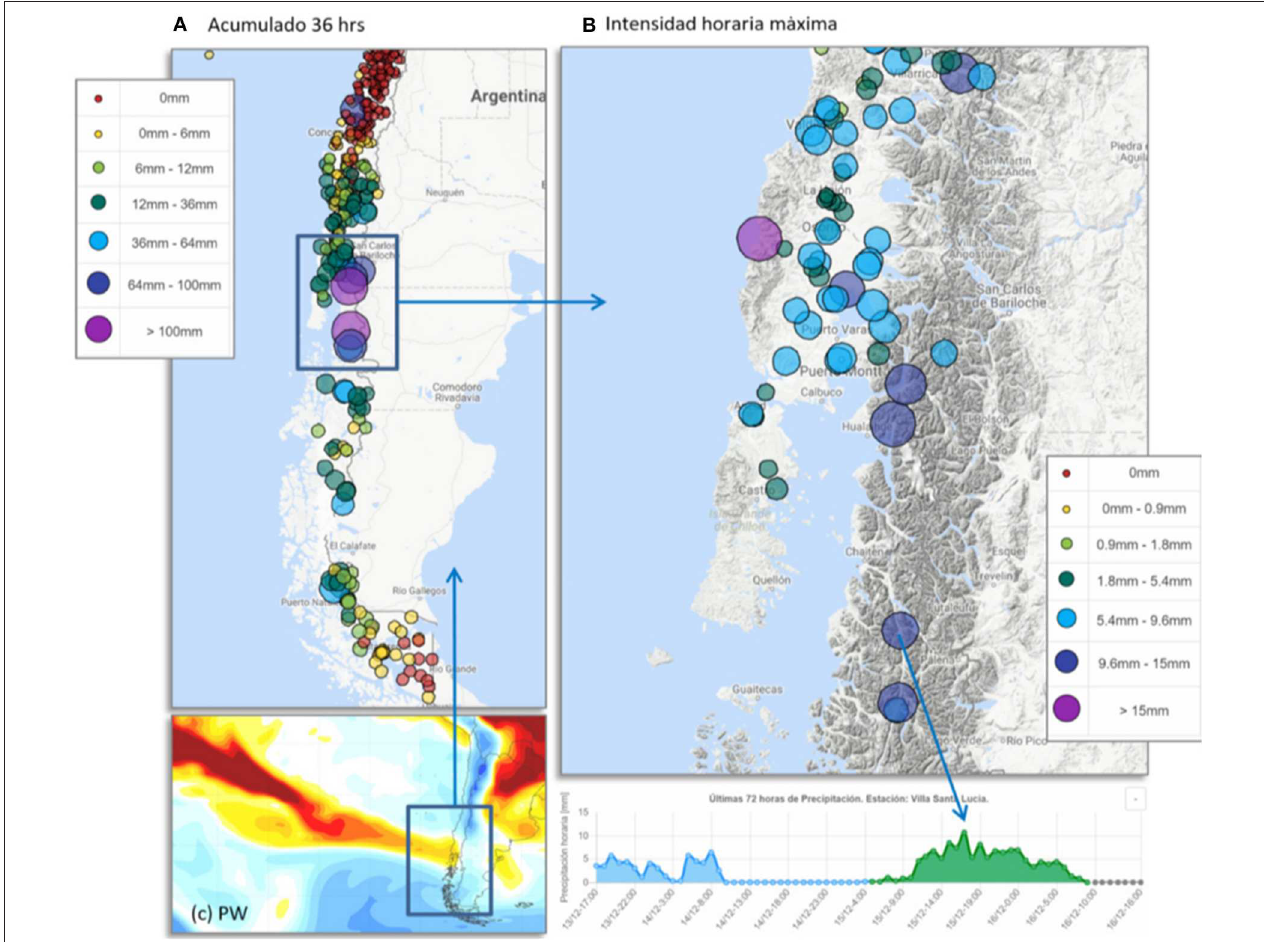
FIGURE 7 | Key aspects of the atmospheric river causing a major flooding in southern Chile. (A) Accumulated precipitation during Dec. 16, 2017. (B) Maximum rain rate (mm/h) that day. (c) Precipitable water MIMICS estimates). Red colors are precipitable water values in excess of 50mm.